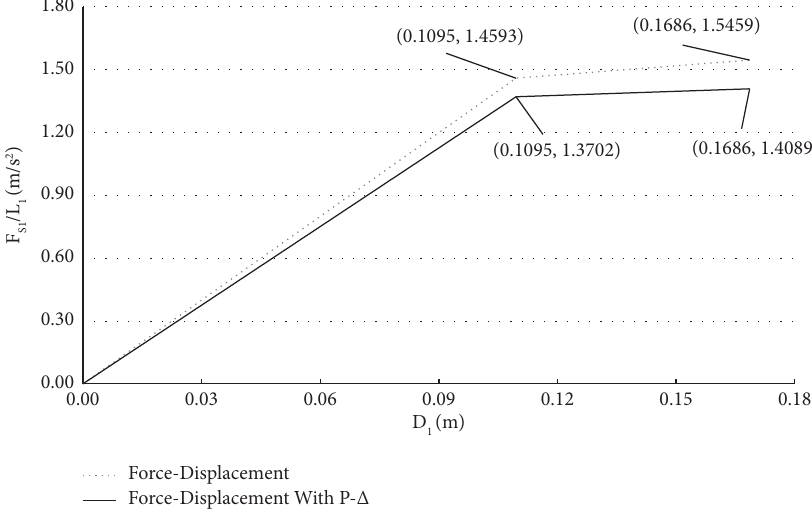
Figure 13: Force-displacement curve of the SDOF system modifed for P − ∆ efect and μ .